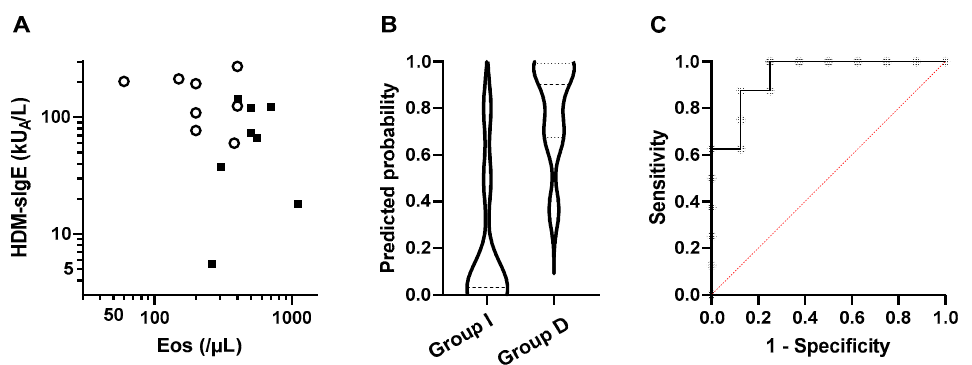
Figure 2. Peripheral blood eosinophil count (Eos) and HDM-sIgE as possible markers for predicting lung function outcomes. ( A ) The peripheral blood eosinophil counts (Eos) and HDM-sIgE levels in Group I (open circles) and Group D (closed squares) are plotted. ( B ) Violin plot graphs of the predicted probability calculated for each group by logistic regression analysis. ( C ) ROC curve for the logistic model.